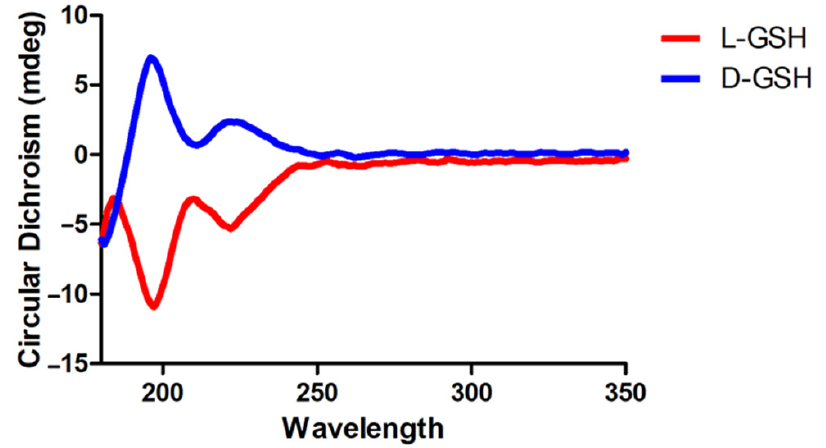
Figure 1. Circular dichroism (CD) spectra of L-chiral form of GSH (L-GSH; red) and D-chiral form of GSH (D-GSH; blue).